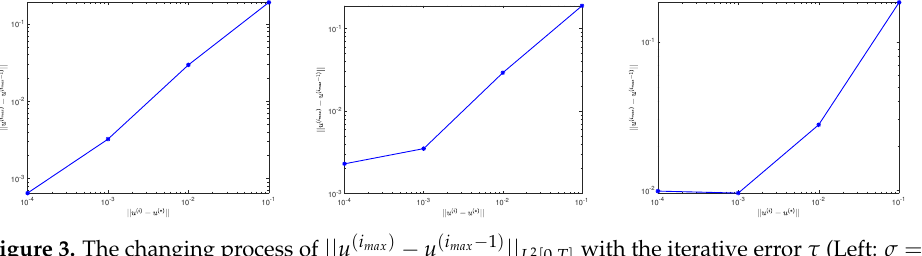
Figure 3. The changing process of || u ( i max ) − u ( i max − 1 ) || L 2 [ 0, T ] with the iterative error τ (Left: σ = 0.05. Middle σ = 0.1. Right: σ = 0.2). Table 1. Behavior of MLMC gradient projection-based optimization ( σ =